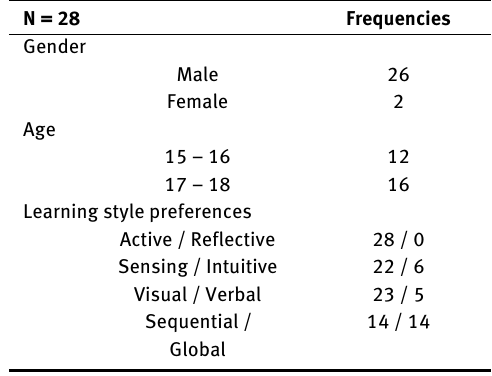
Table 1: Demographics of the students